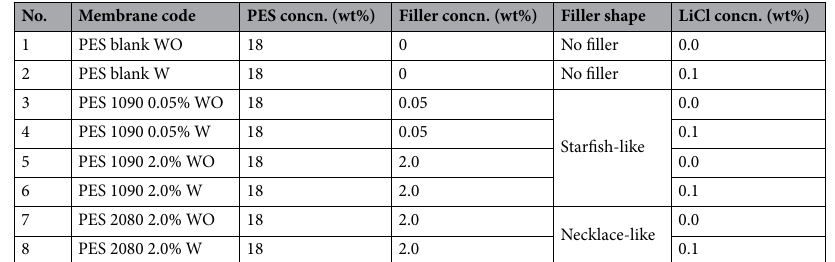
No. Membrane code PES concn. (wt%) Filler concn. (wt%) Filler shape LiCl concn.